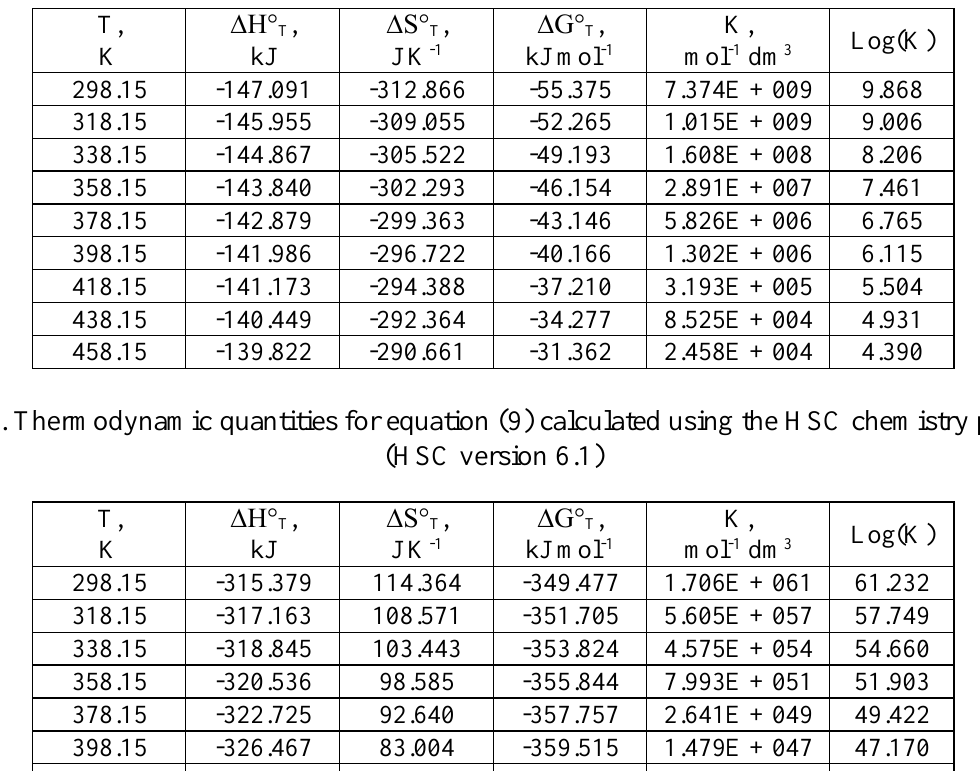
Table 4. Thermodynamic quantities for equation (4) calculated using the HSC chemistry